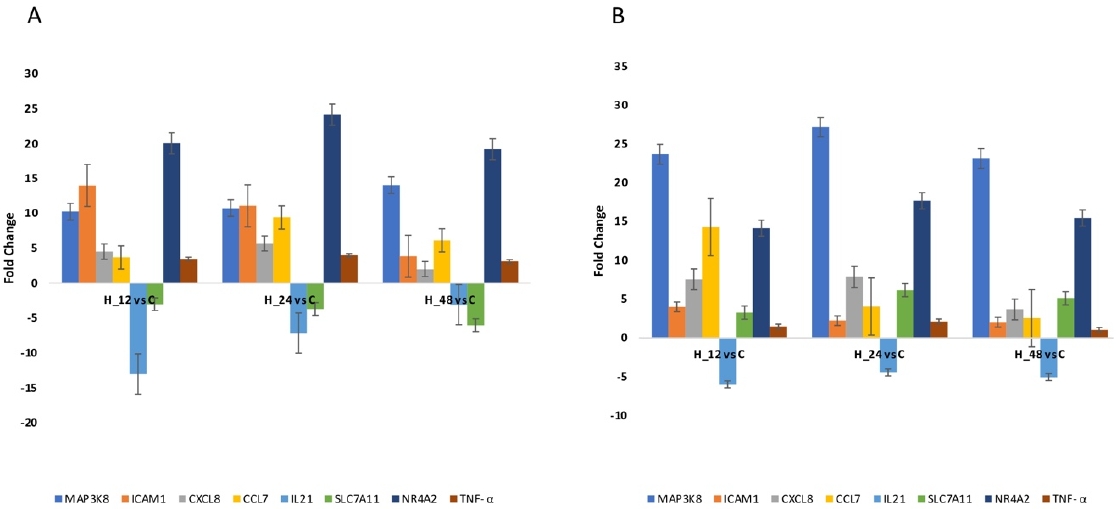
Figure 2. Changes in the expression patterns of genes related to oxidative stress in an Ishikawa cell culture exposed to cisplatin ( A ) and salinomycin ( B ), in comparison to the control obtained via RTqPCR ( p < 0.05) . (+)—overexpression in comparison to the control; ( − )—downregulated in com ‐